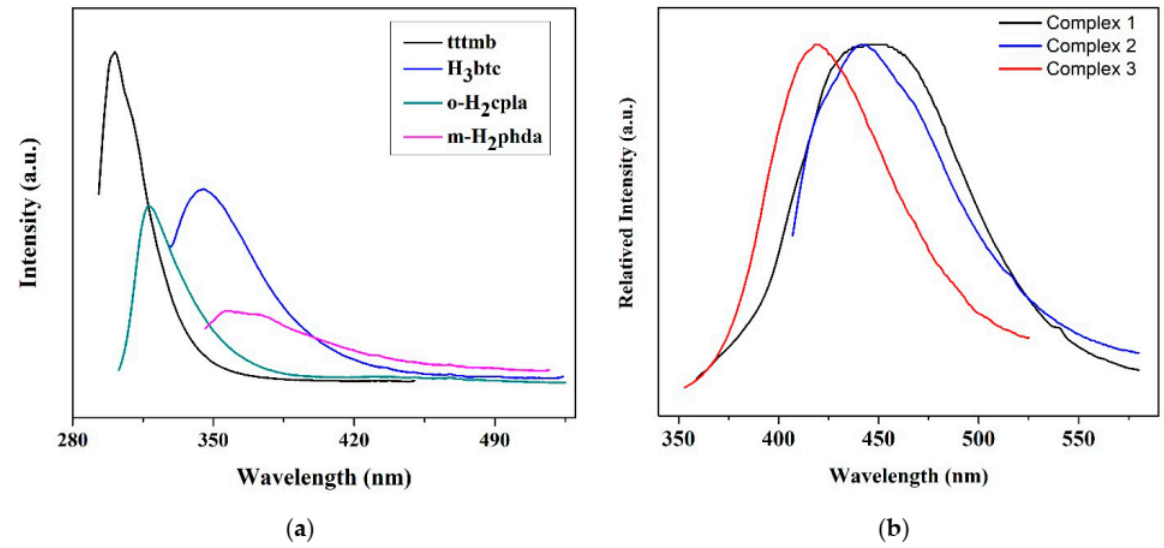
Figure 6. Solid-state photoluminescent spectra of ( a ) free ligands and ( b ) Complexs 1 – 3